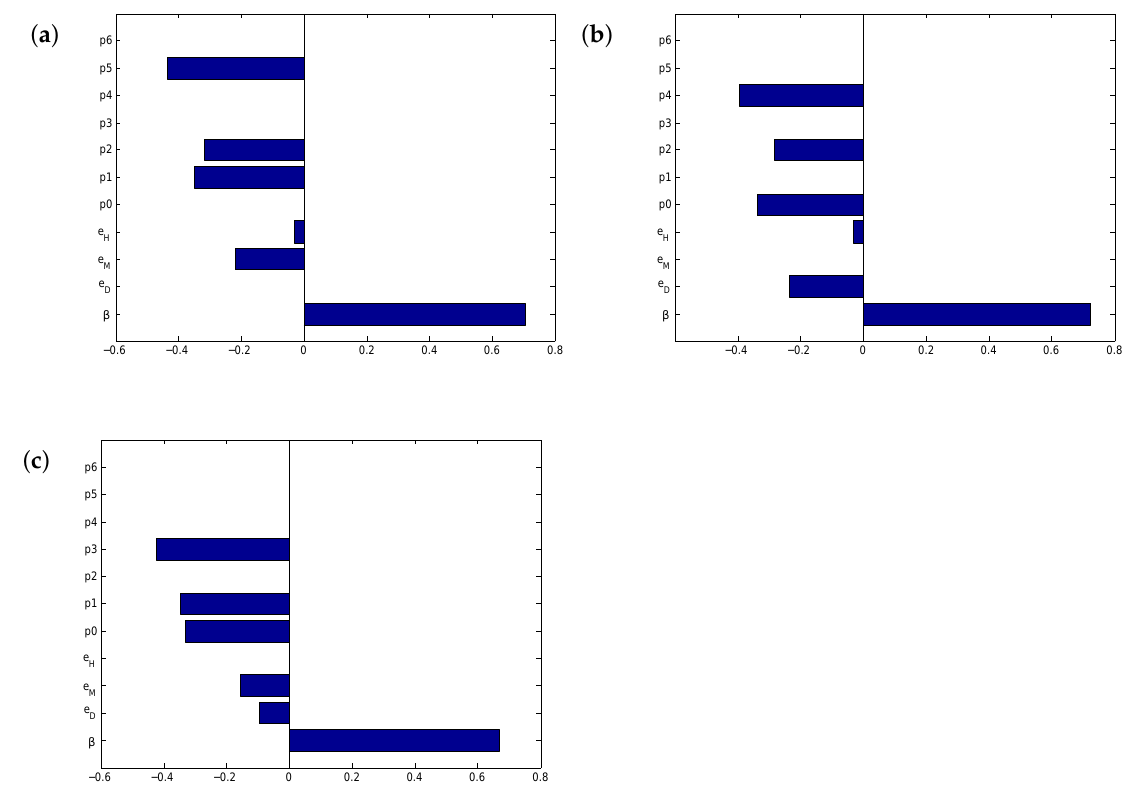
Figure 2. PRCCs for limiting cases: ( a ) non-compliance with physical distancing rules, ( b ) shortage of face masks and ( c ) no hand sanitizing. The outcome variable is the daily risk of infection before vaccination, r 1 , and we consider high transmissibility (0.85 ≤ β ≤